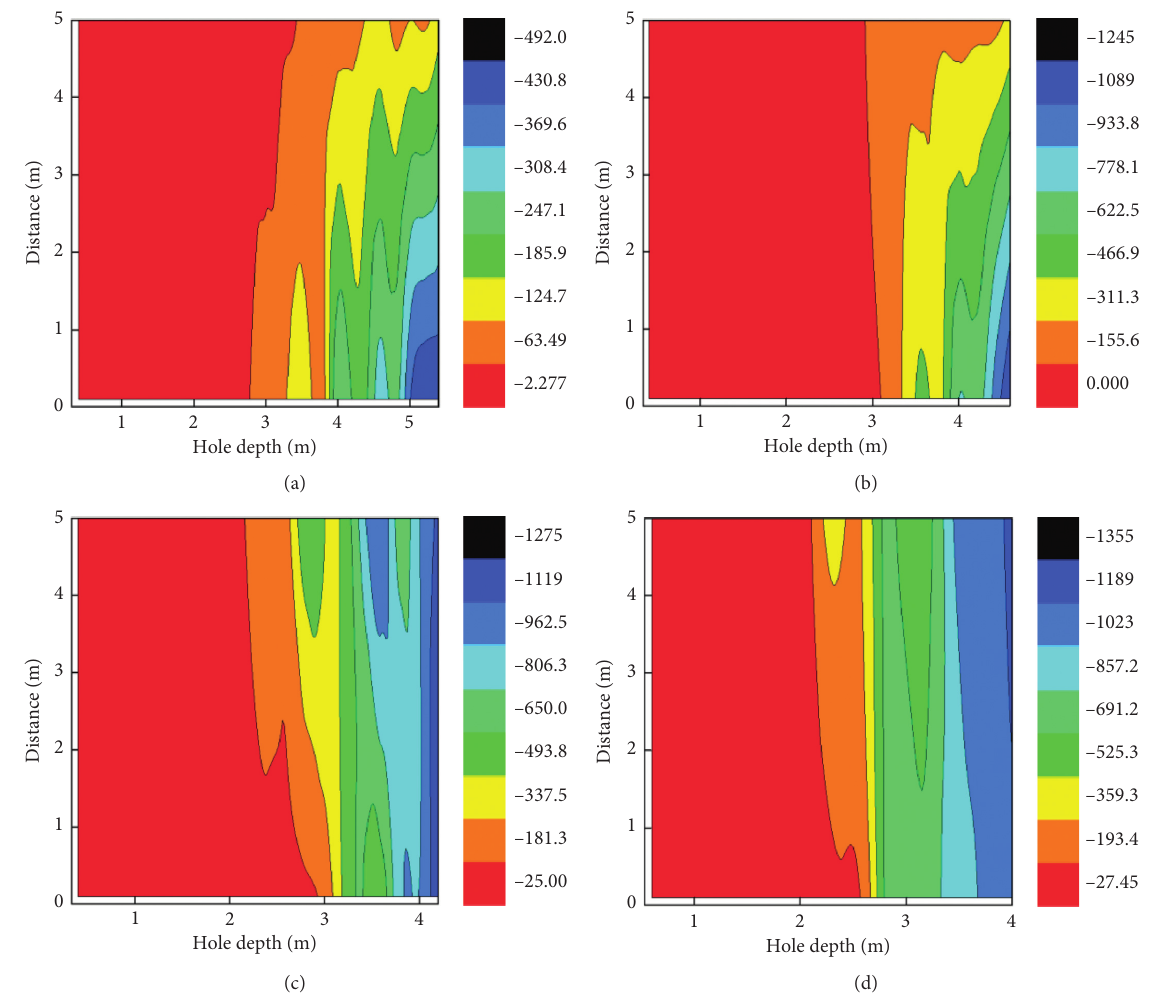
Figure 14: Nephograms of absolute changes of ultrasonic wave velocity. (a) First blasting, (b) second blasting, (c) third blasting, and (d) fourth blasting (unit: